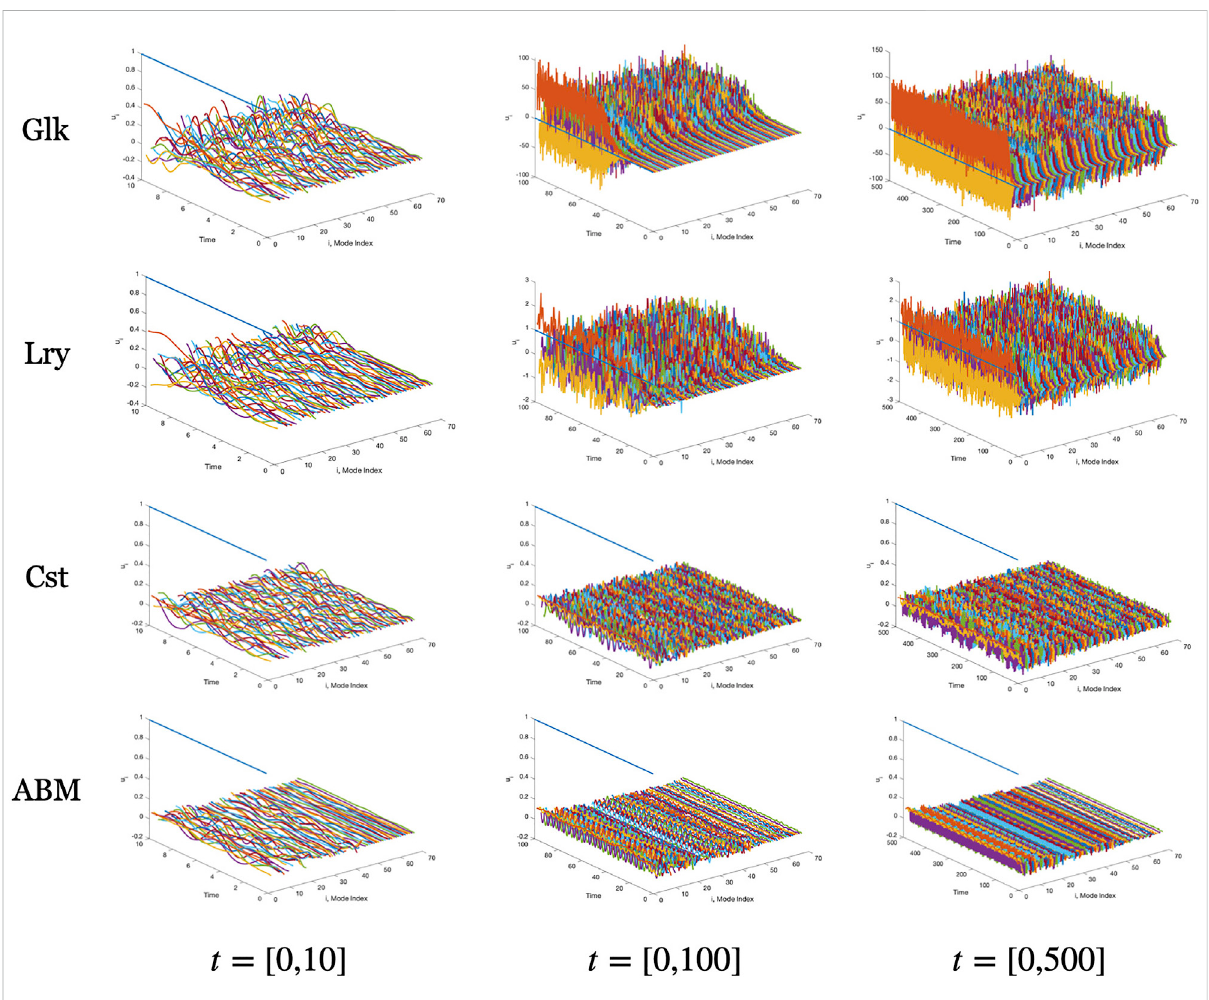
Temporalbehaviorofbasiscoef fi cientsforstandardPOD(Glk),Leray- fi ltered(Lry),Constrained(Cst),andABM-ROMsolutionsofturbulentpipe fl ow at Re = 5300 over (convective) time intervals t ∈ [0, 10] [0.100], and